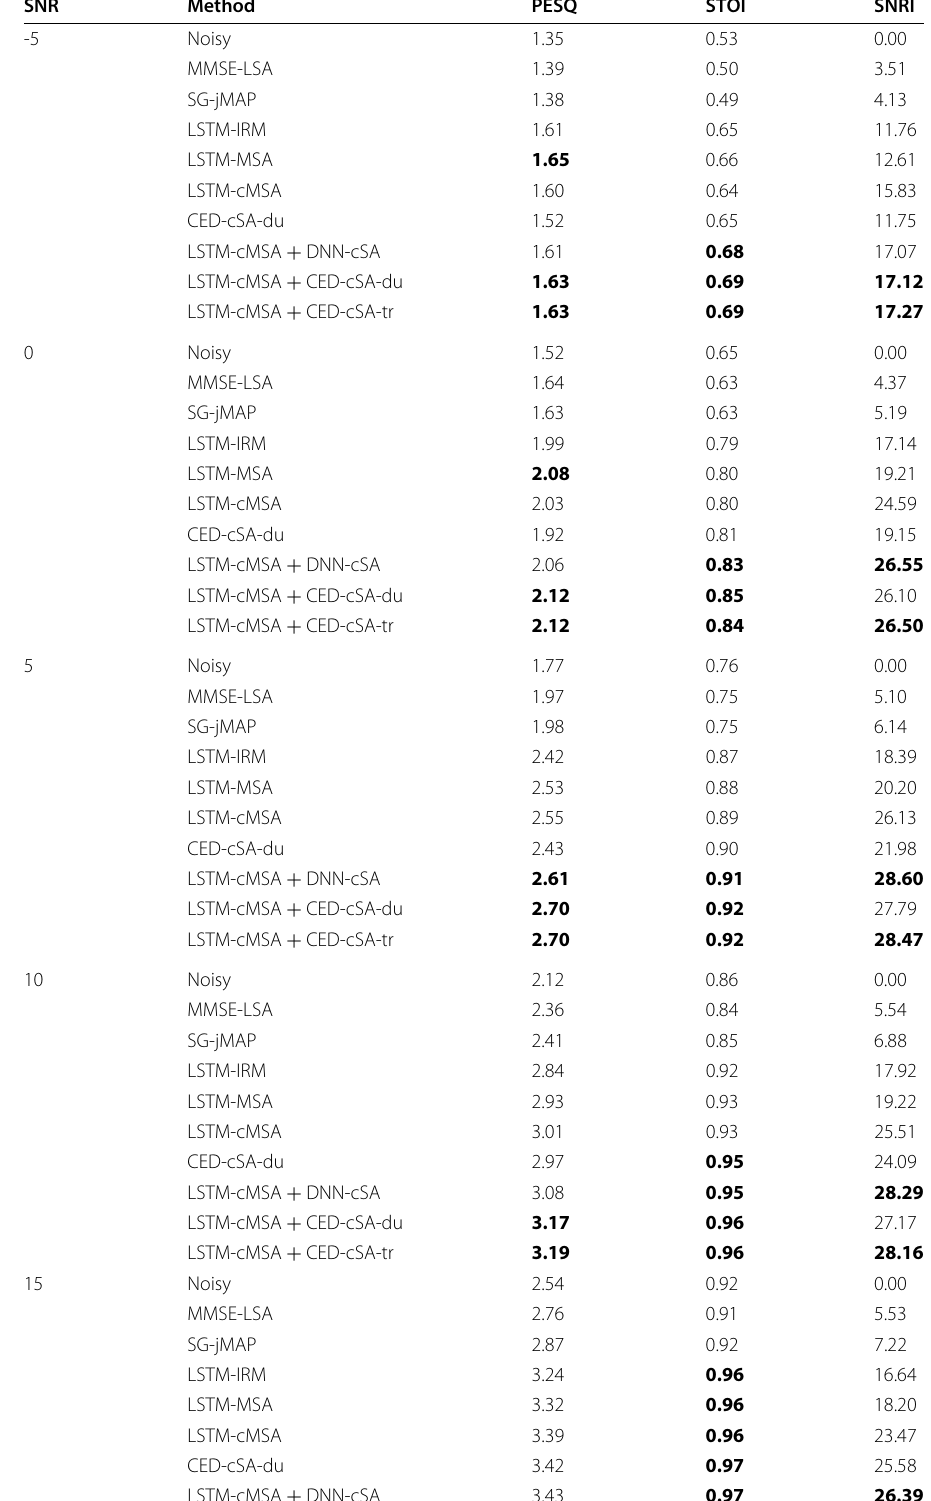
Table 1 Instrumental measures for baseline and proposed approaches averaged over seen noise types of the development set data. Note that the SNR conditions of − 5 and 15 dB are unseen during training, whereas the remaining SNRs have been seen. Best two approaches are in boldface